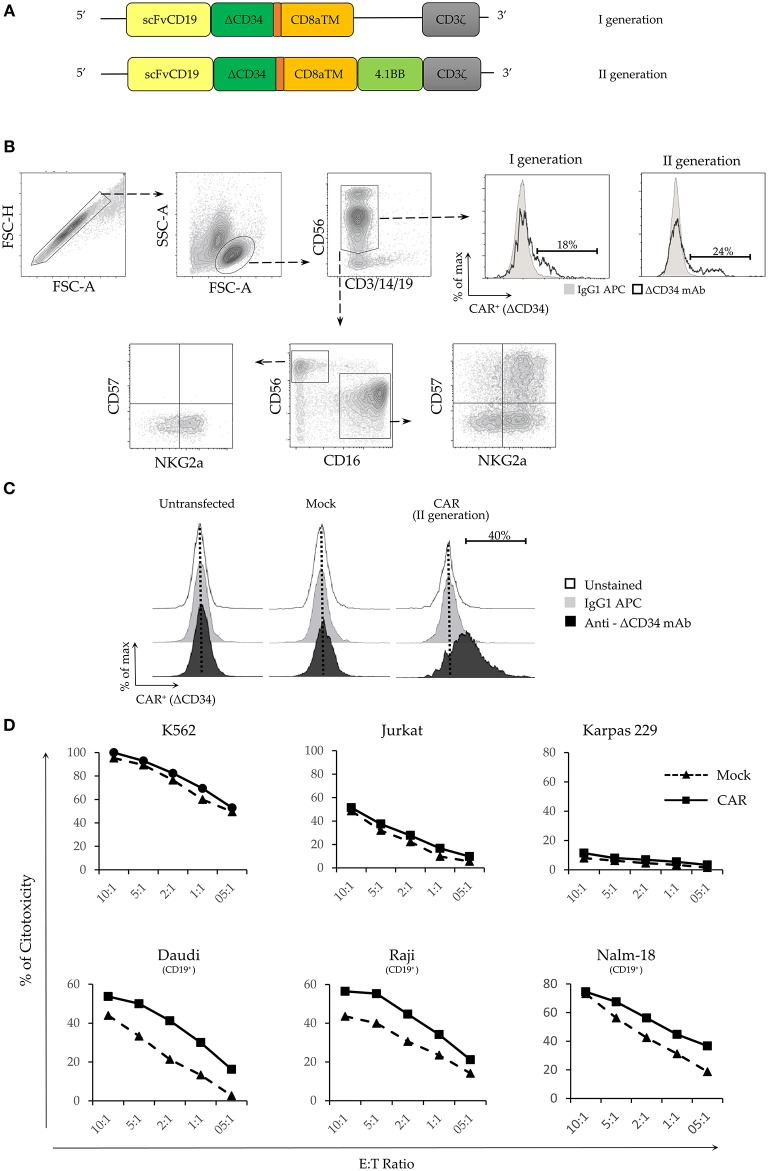
Electroporation of a functional CAR-antiCD19 transgene in NK cells increases their cytolytic activity. (A) Schematic representation of the different domains of the two CAR constructs. (B) Representative gating strategy used to test the electroporation efficiency of I and II generation CAR constructs in the different NK cell populations. (C) Electroporation efficiency of CD19+CAR plasmid in untransfected, mock-transfected and CAR-transfected activated NK cells. CAR expression was evaluated on DAPI-negative live cells using the delta (Δ) CD34 marker. Cytometric profiles of unstained (empty profile), isotype stained (gray profile) and anti-ΔCD34 mAb stained (black profile) NK cells are shown. (D) Percentage of cytotoxicity was evaluated by flow cytometry on propidium iodide (PI) positive target cells. CD19− cell lines (upper panel) and CD19+ (lower panel) were used as target cells. Effector: Target (E:T) ratios are indicated. A representative experiment out of 3 performed is shown.